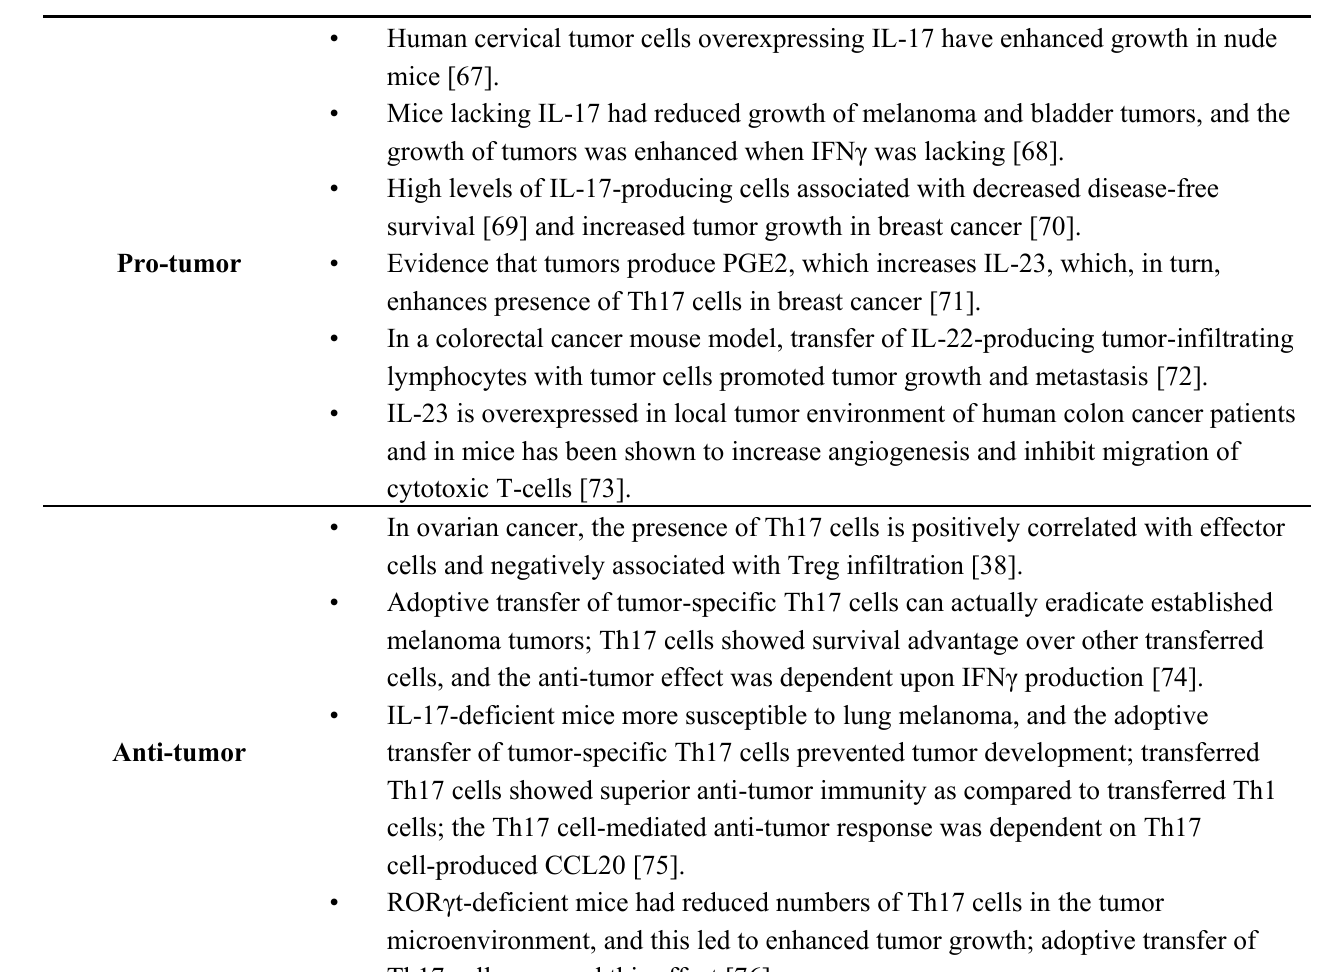
Table 2. Highlights of the literature reviewing the pro- versus anti-tumor effect of Th17